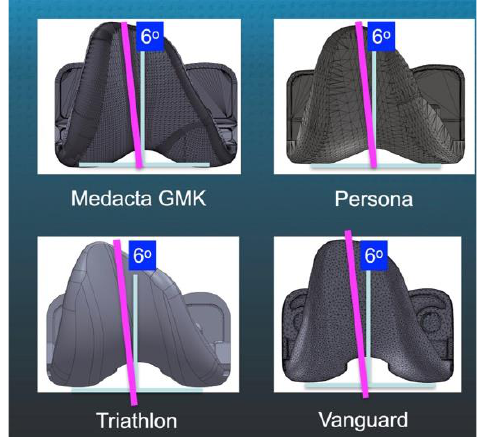
Figure 1. Images of four representative brands of right-sided MA D -FC (femoral component designed for mechanical alignment) show the line (magenta) denoting the trochlear groove that is oriented 6° lateral relative to a line perpendicular (blue) to the distal femoral joint line.